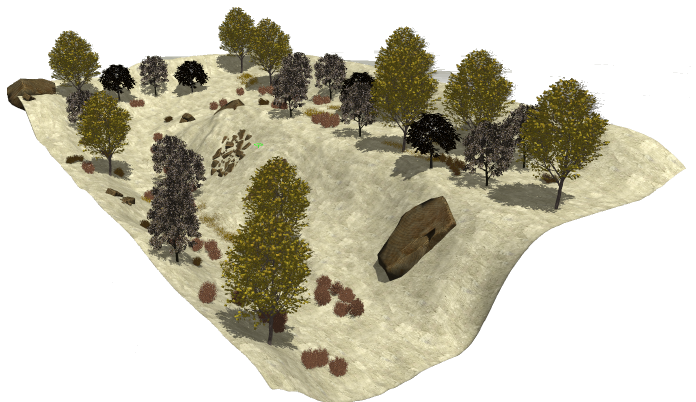
Figure 7. The rugged hillside environment modeled in